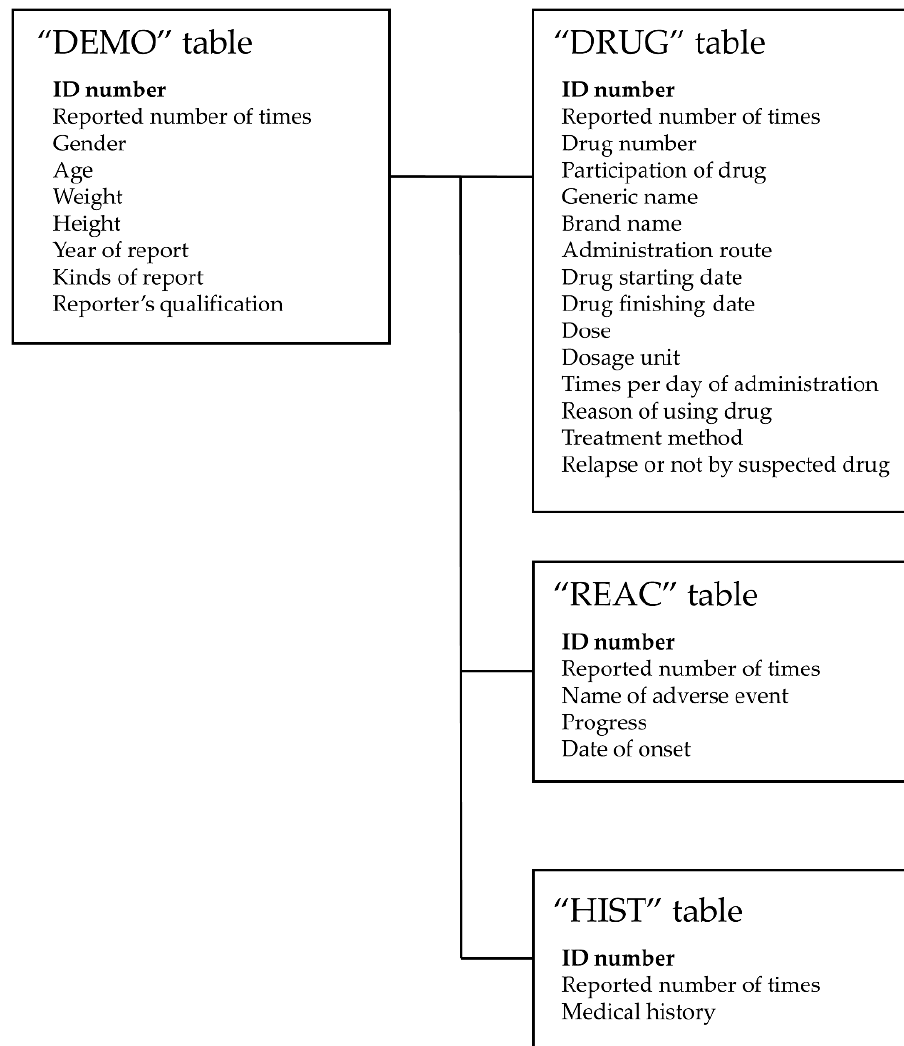
Figure 2. The four information tables included in JADER.